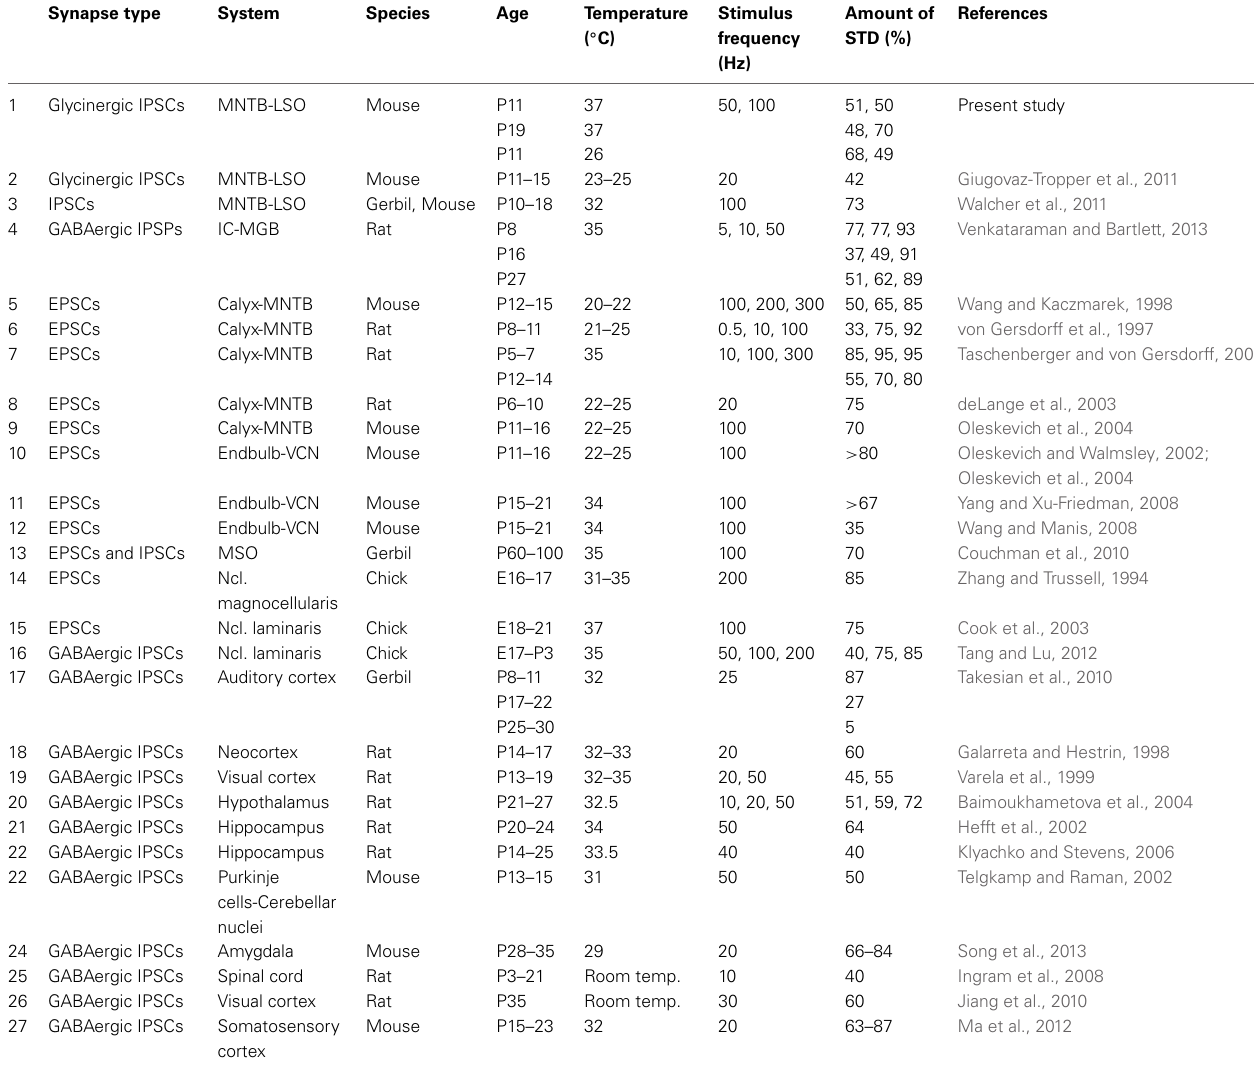
Table 5 | Comparison of STD in several neuronal